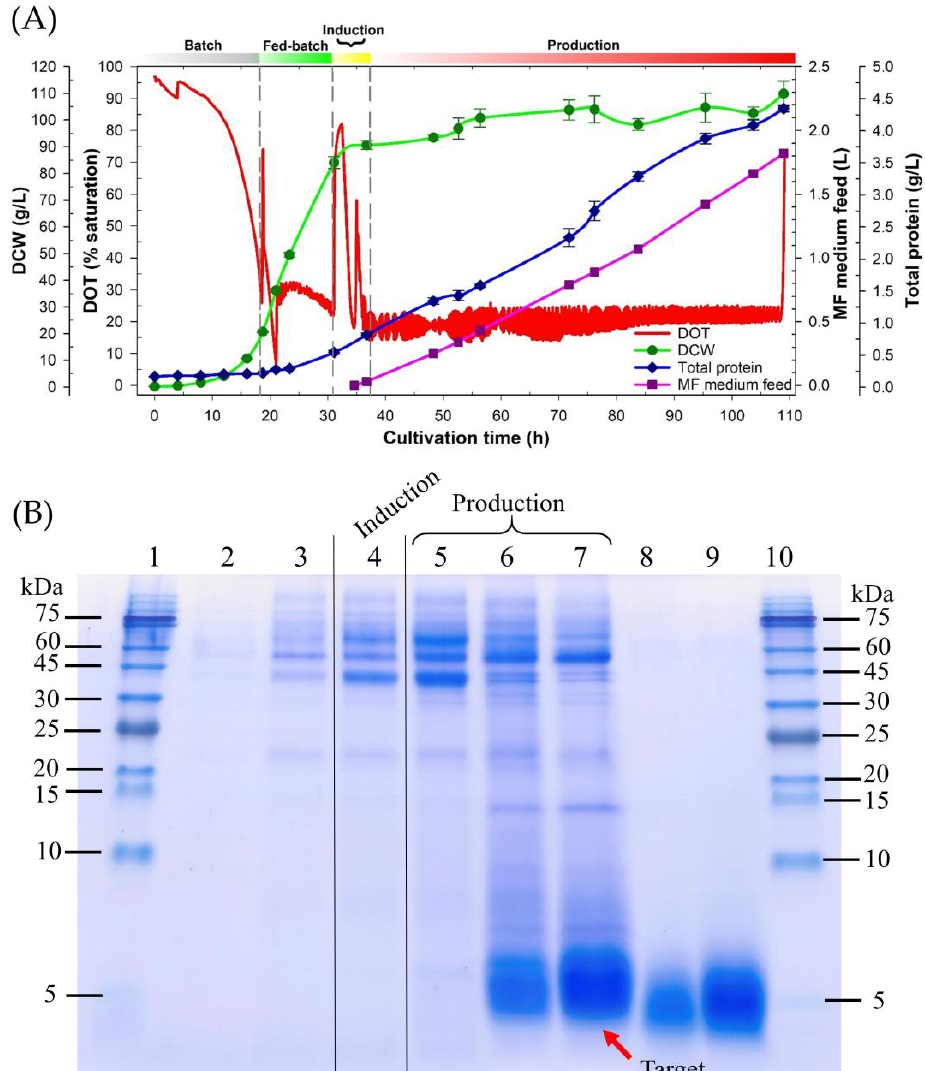
Figure 3. ( A ) DCW, DOT, MF medium feed, and total protein profiles during the improved fermentation process of the CAP3 candidate production (process time = 108.95 h). Error bars indicate the standard deviation of the technical triplicates. ( B ) Tricine SDS-PAGE analysis of the culture supernatant from the expression of the CAP3 candidate utilizing the improved fermentation process. The samples in lanes 1 and 10 were molecular weight markers; lane 2 was the finished glycerol batch stage; lane 3 was the finished glycerol fed-batch stage; lane 4 was the finished methanol induction stage; lanes 5, 6, and 7 were 24, 48, and 72 h of the production stage, respectively; lanes 8 and 9 were 1.76 and 3.52 g/L of the CAP2, respectively. The arrow represents the target peptide CAP3 ( ≈4.3 kDa).